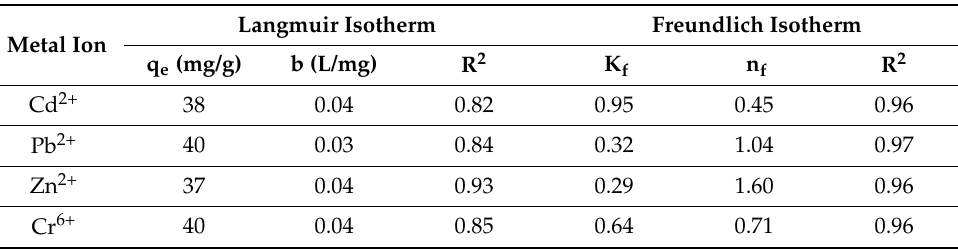
Figure 6. The Langmuir and Freundlich isotherms for the adsorption of Cr 6+ , Cd 2+ , Pb 2+ and Zn 2+ on FAC. Table 3. Correlation coefficients (R 2 ) and constants for the Langmuir and Freundlich isotherms for Pb 2+ , Cd 2+ , Zn 2+ and Cr 6+ adsorption on